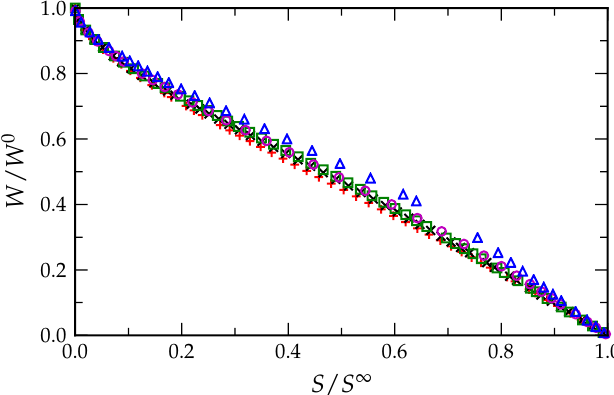
Figure 5. Relation between the interaction energy W [ η k σ ] and the independent Fermion entropy S [ η k σ ] in the ground-state of the half-filled Hubbard model for various finite lattices with periodic boundary conditions. The results were obtained by exact Lanczos diagonalizations on finite 1D rings having N a = 6 (plus signs), N a = 10 (crosses) and N a = 14 sites (squares), as well as for 2D square-lattices having N a = 2 4 (circles) and N a = 3 4 sites (triangles). Reproduced with permission from × × Reference [72]. c (cid:13) American Physical